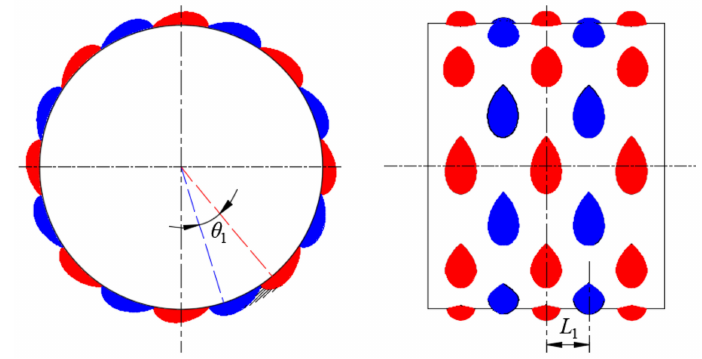
Figure 5. Definition of tine trajectory and